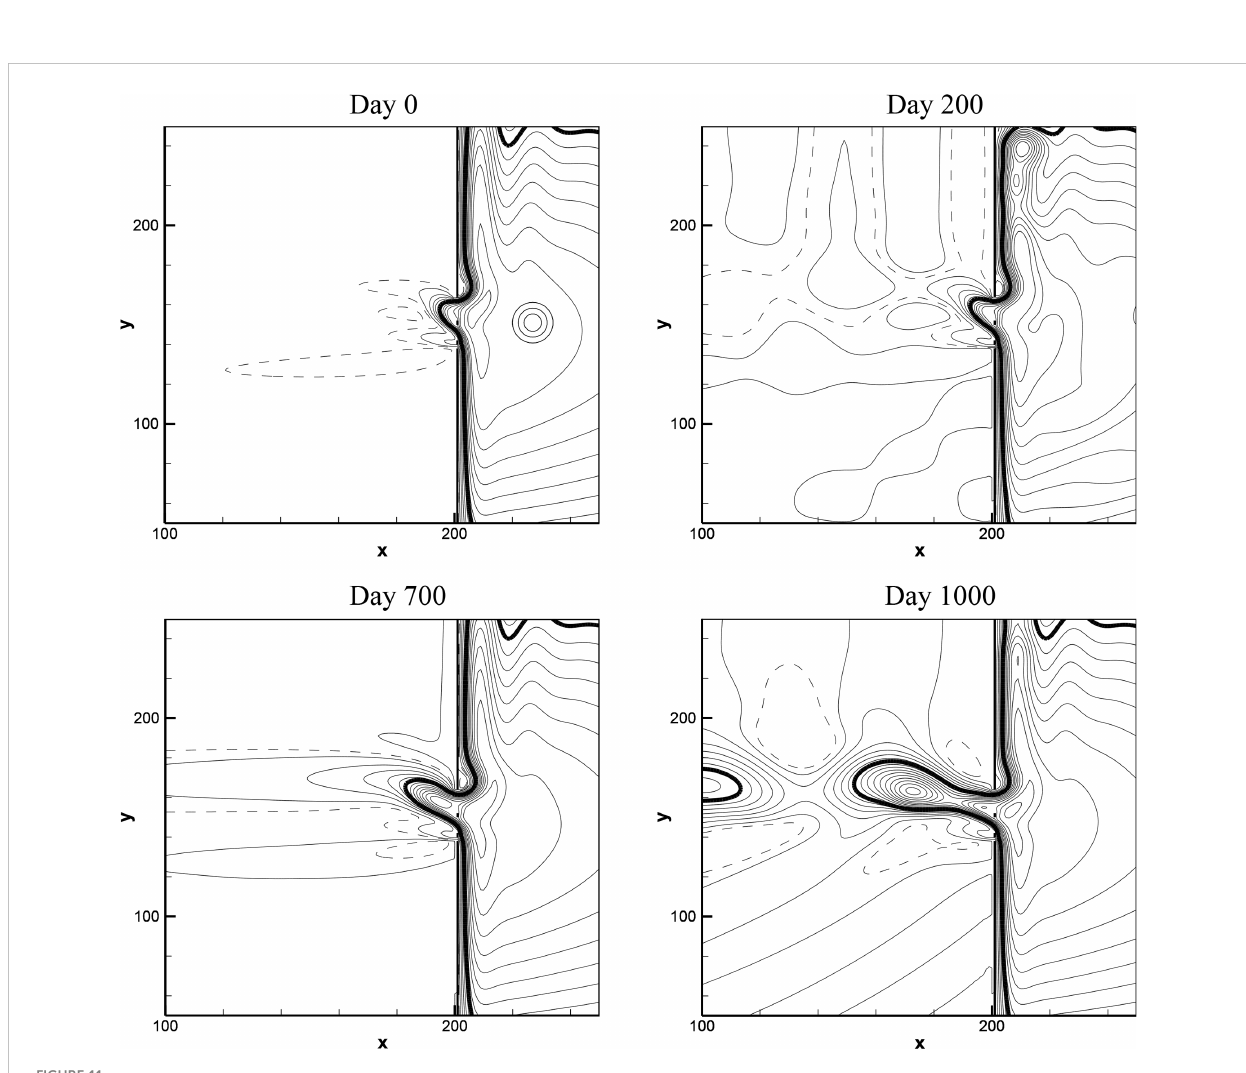
FIGURE 11 Same as Figure 9, except for the critical WBC path impinged by an anticyclonic eddy. The critical strength of the eddy is y c = 41,000 m 2 s − 1 . WBC, western boundary